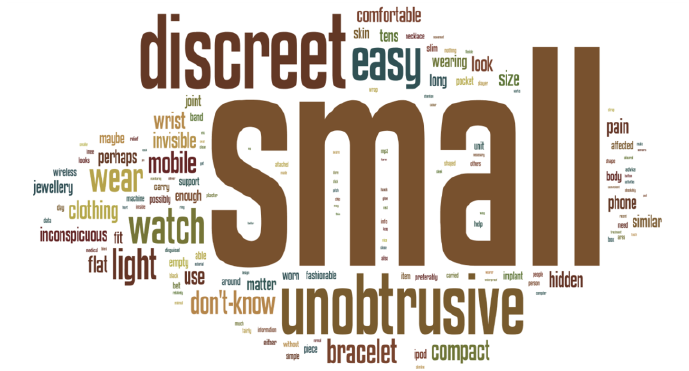
Figure 5. Word cloud generated for the question of how a wearable device should look. The cloud provides a graphical representation of the frequency at which specific words are used.